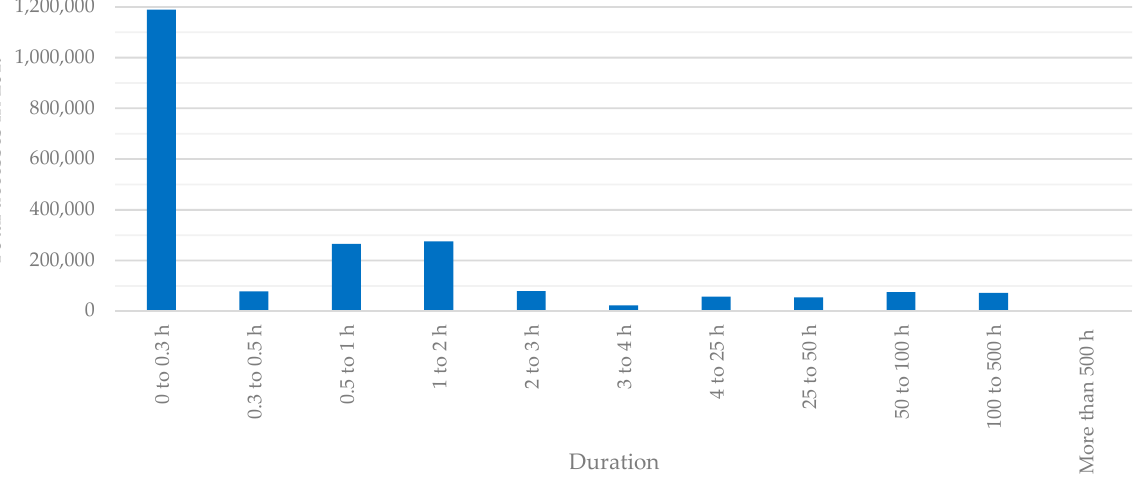
Figure 12. Stop duration distribution. Figure 13. The difference is due to two causes: